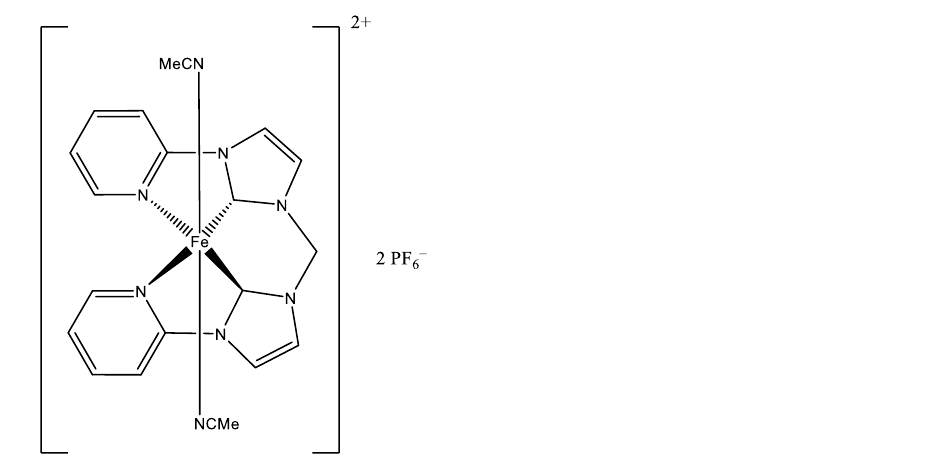
Figure 6. Structure of an iron(II) complex bearing a tetradentate bis(pyridyl- N- heterocyclic carbene) ligand. Adapted from [26].